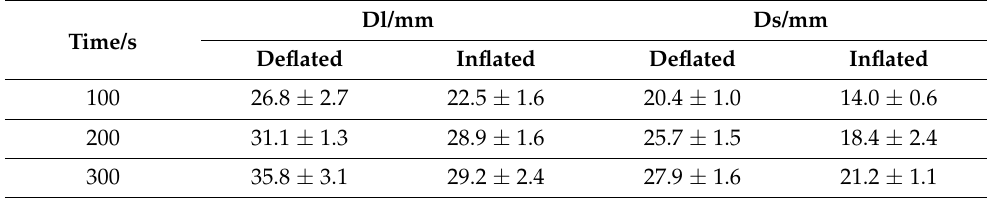
Table 6. Experimental data (ablation power 50 W).